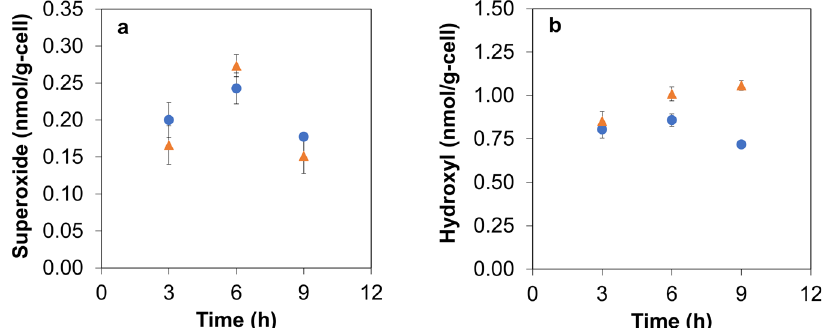
Fig. 3 Reactive species time pro fi le in the absence and presence of AgNP generated oxidative stress. ( indicates control culture; indicates culture treated with 25 ppm AgNP). a The superoxide radical levels increased during the mid-log phase (6th h) of growth (on exposure to AgNPs), and then dropped, when compared to control ( p -value = 0.0419). b The hydroxyl radical concentration in the presence of a lower concentration of AgNP, showed increased levels at 9th h when compared to the control ( p -value = 0.0357). Values are expressed as mean ± SD, n = 3.